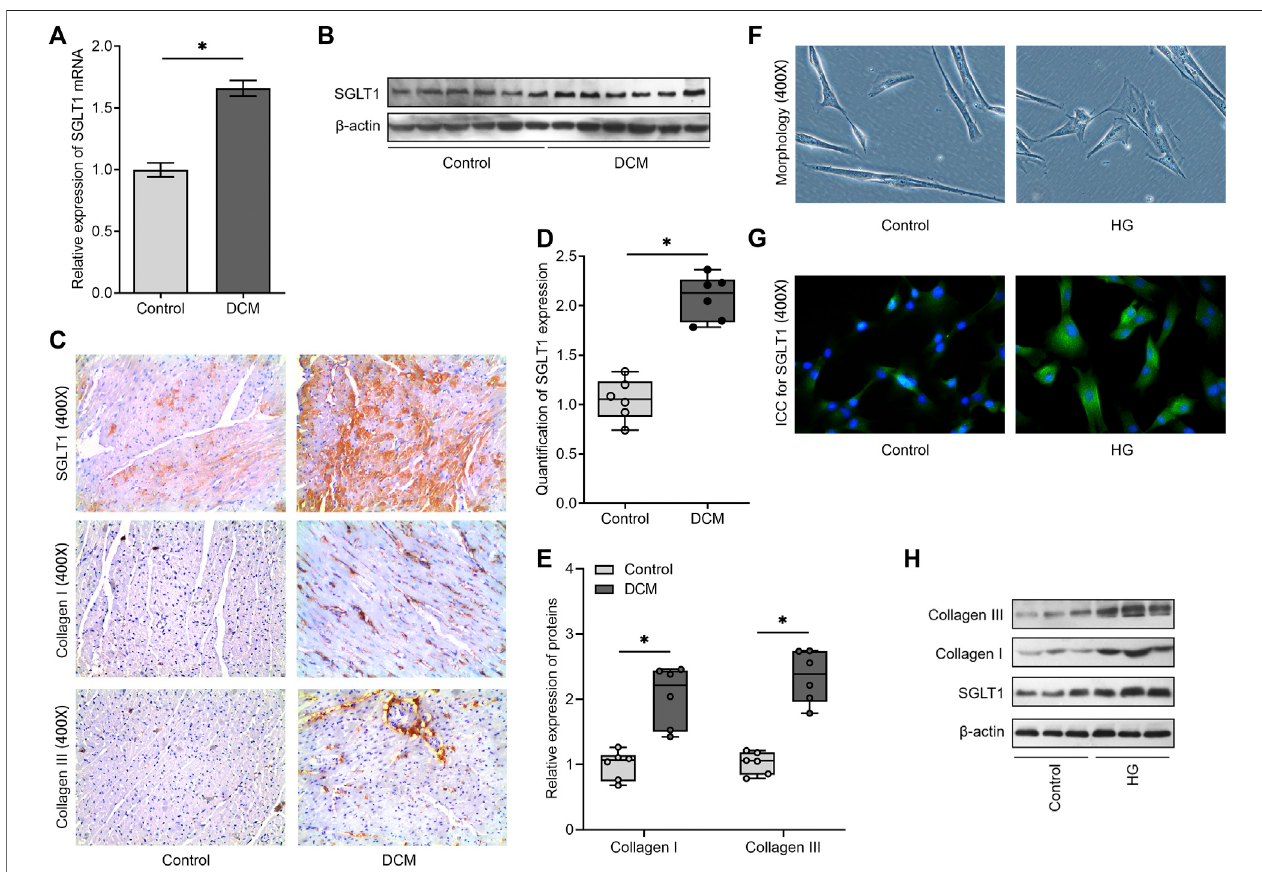
FIGURE 2 | SGLT1 is downregulated in the experimental diabetic cardiac fi brosis model and high-glucose – induced CFs. (A) The mRNA level of SGLT1 was detectedusingRT-qPCR( n (cid:2) 6). (B) TheproteinlevelofSGLT1wasanalyzedusingwesternblotanalysis( n (cid:2) 6). (C) TheproteinlevelsofSGLT1,collagenI,andcollagen III were evaluated using immunohistochemical staining. Relative expression of SGLT1 (D) and collagen I and collagen III (E) was found using semiquantitative analysis based on immunohistochemistry. (F) The morphology of CFs with or without high-glucose stimulation was imaged under an optical microscope. (G) The protein level of SGLT1 was analyzed by immuno fl uorescent staining in high-glucose – induced CFs. (H) The protein levels of SGLT1, collagen I, and collagen III were analyzed using western blot analysis in high-glucose – induced CFs ( n (cid:2) 3).